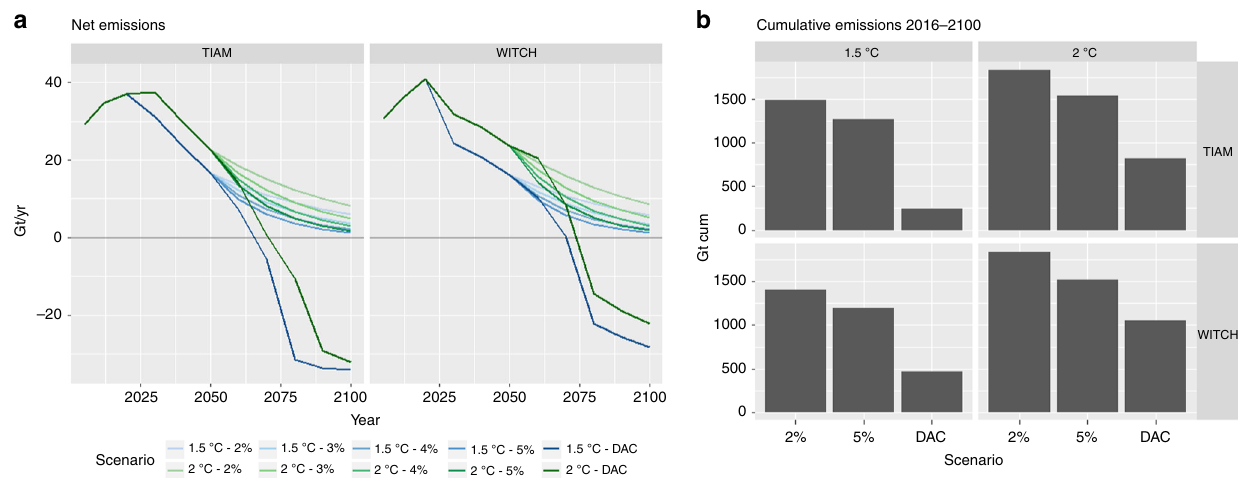
Fig. 7 Emission pathway and cumulative emissions in DACCS failure scenarios. The left panels a shows the emission pathways of the original DACCS scenarios and those with no DACCS and exogenous emission reductions between 2 and 5%. The right panels b show the 2016 – 2100 cumulative emissions of CO 2 . In this case, carbon emissions for WITCH include both fossil burning, industry and land